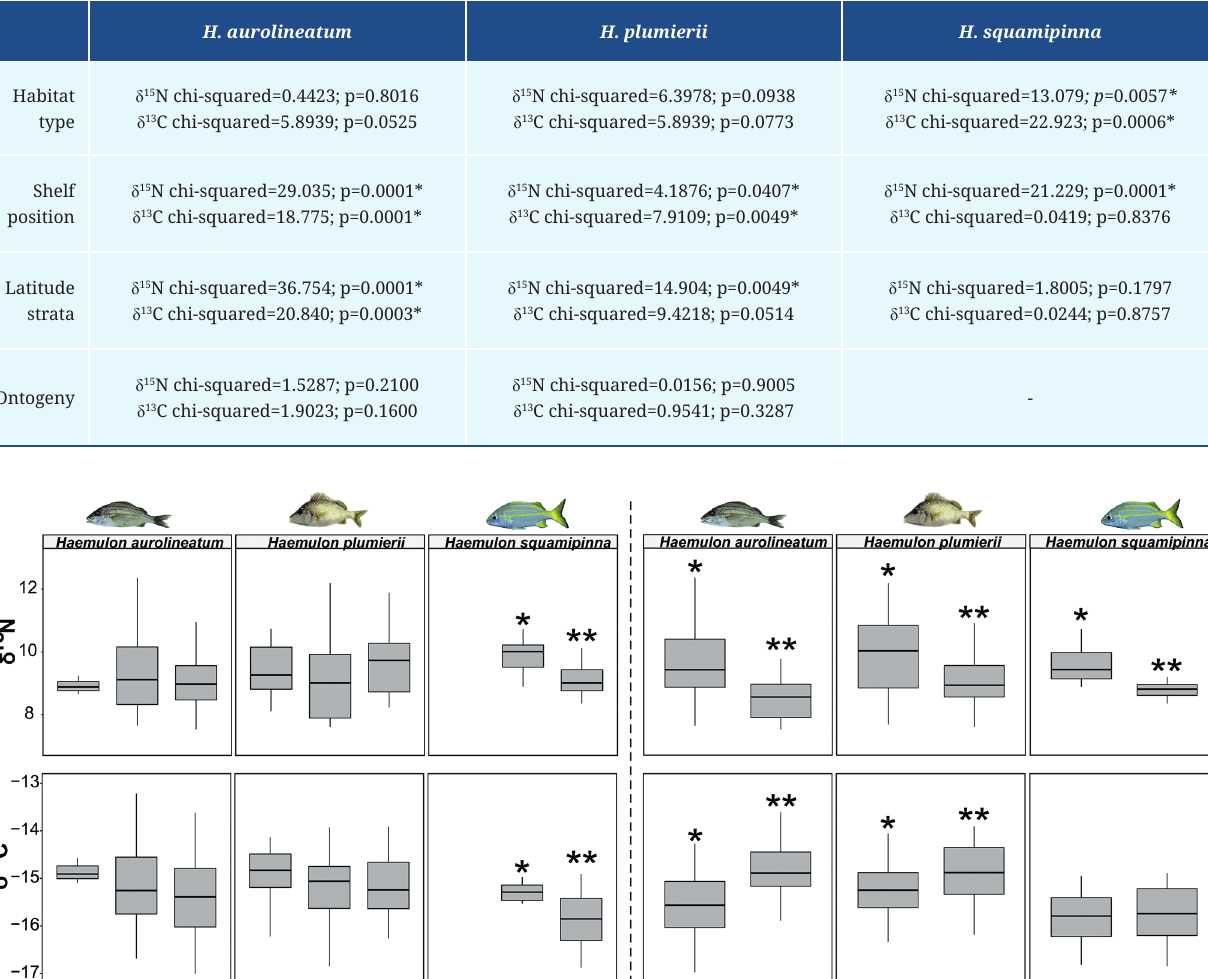
TABLE 3 | Statistic differences in δ 15 N and δ¹³ C values by habitat type, shelf position, latitude strata and ontogeny for Haemulon aurolineatum , H. plumierii , and H. squamipinna caught in Northeast Brazilian continental shelf. All caught specimens of H. squamipinna were considered adults, not allowing ontogenetic analysis. Significant values are identified by *.